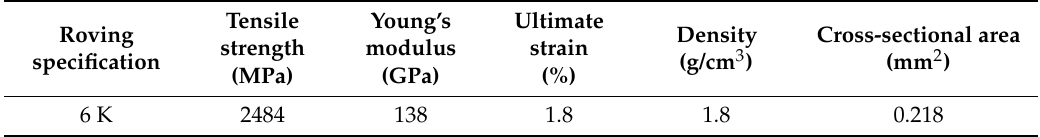
Table 1. Mechanical properties of carbon